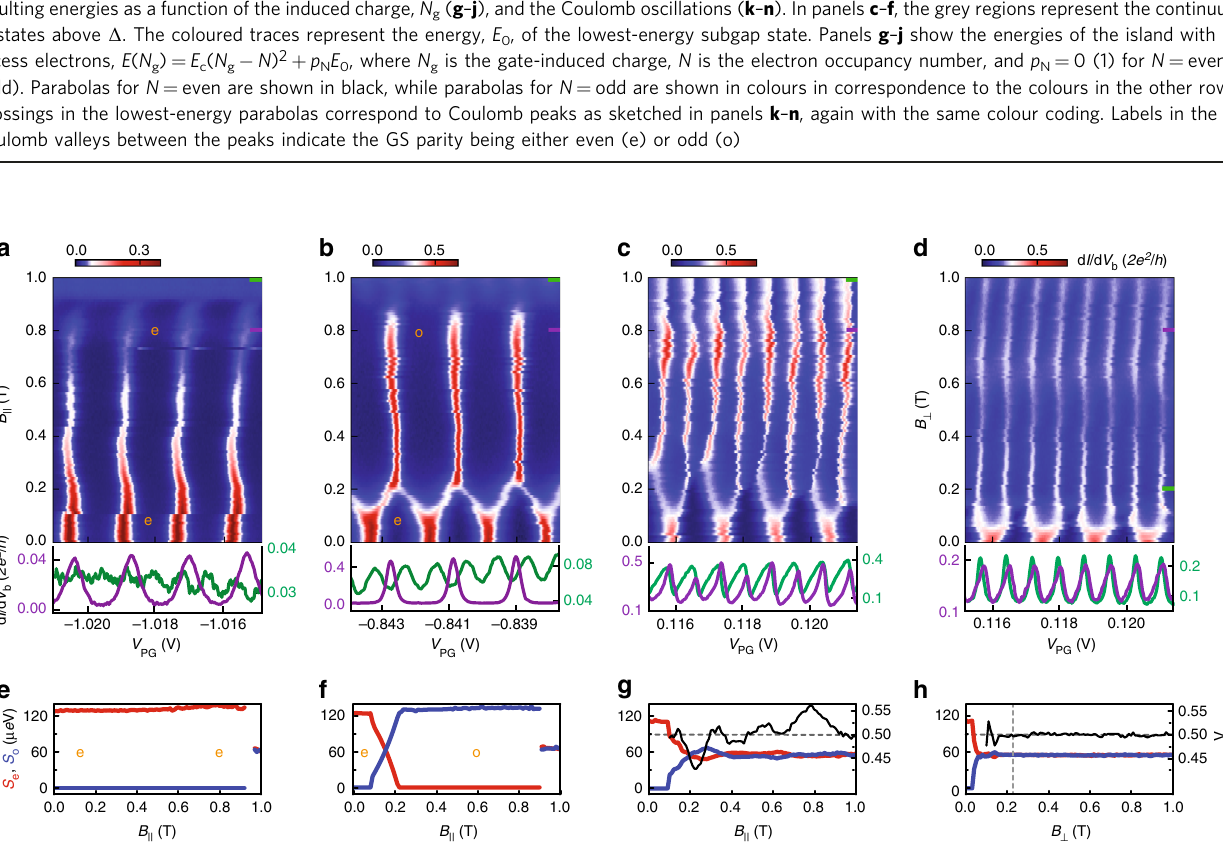
Fig. 2 Four representative evolutions of Coulomb peaks, corresponding to the four columns ( c – n ) in Fig. 1. Top row panels: d I /d V b as a function of V PG and B ∥ ( a – c ) or B ⊥ ( d ). Below are typical linecuts at different B - fi elds indicated by the purple and green lines. ( e – h ) Even and odd peak spacings, S (blue) on the left axis, and peak height ratio, Λ (black) on the right axis, vs. B - fi eld, for the valleys labelled e/o in a and b and for the average spacings in c and d , respectively. Here and in other fi gures, the linewidths of S e and S o curves correspond to 5 µ eV, in accordance with the lock-in excitation energy. a The 2 e -periodicity with even-parity valleys persists up to 0.9 T, above which quasiparticle poisoning occurs. b The 2 e -periodic peaks split at ~0.11 T and merge again at ~0.23 T. For B ∥ > 0.23 T, the oscillations are again 2 e -periodic, but here the GS parity is odd, consistent with Fig. 1h. c 2 e -periodicity transitioning to uniform 1 e -periodicity at B ∥ ≈ 0.35 T, accompanied by peak spacing and peak height ratio oscillations up to 0.9 T (see also panel g ). d 2 e - periodicity transitioning to 1 e -periodicity at B ⊥ = 0.18 T (the vertical dashed line), coinciding with the critical B - fi eld of the Al layer (see Supplementary Fig. 3). Above the critical fi eld, peak heights are constant (see linecuts) and the even/odd peak spacings are equal ( h ). A few common offsets in V PG are introduced to compensate the shifts in gate voltage, and the raw data are listed in Supplementary Fig. 4